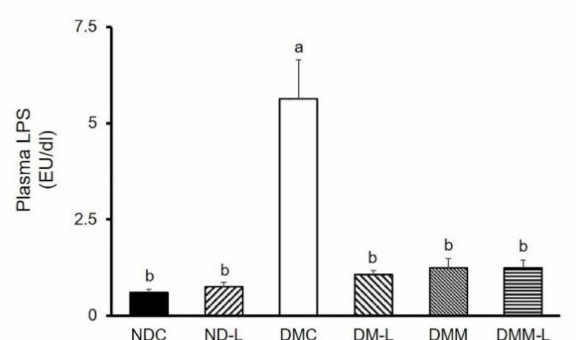
Figure 6. E ff ects of L. paracasei HII01 on the plasma LPS levels in experimental groups. NDC, normal control rats; ND-L, normal control rats supplemented with L. paracasei HII01 (10 8 CFU / day); DMC, diabetic rats control; DM-L, diabetic rats supplemented with L. paracasei HII01 (10 8 CFU / day); DMM, diabetic rats treated with metformin 30 mg / kg; DMM-L, diabetic rats supplemented with combination of L. paracasei HII01 (10 8 CFU / day) and metformin 30 mg / kg. LPS, lipopolysaccharide. All data are expressed as mean ± SEM. Di ff erent lowercase letters indicate significant di ff erences among di ff erent groups ( p <